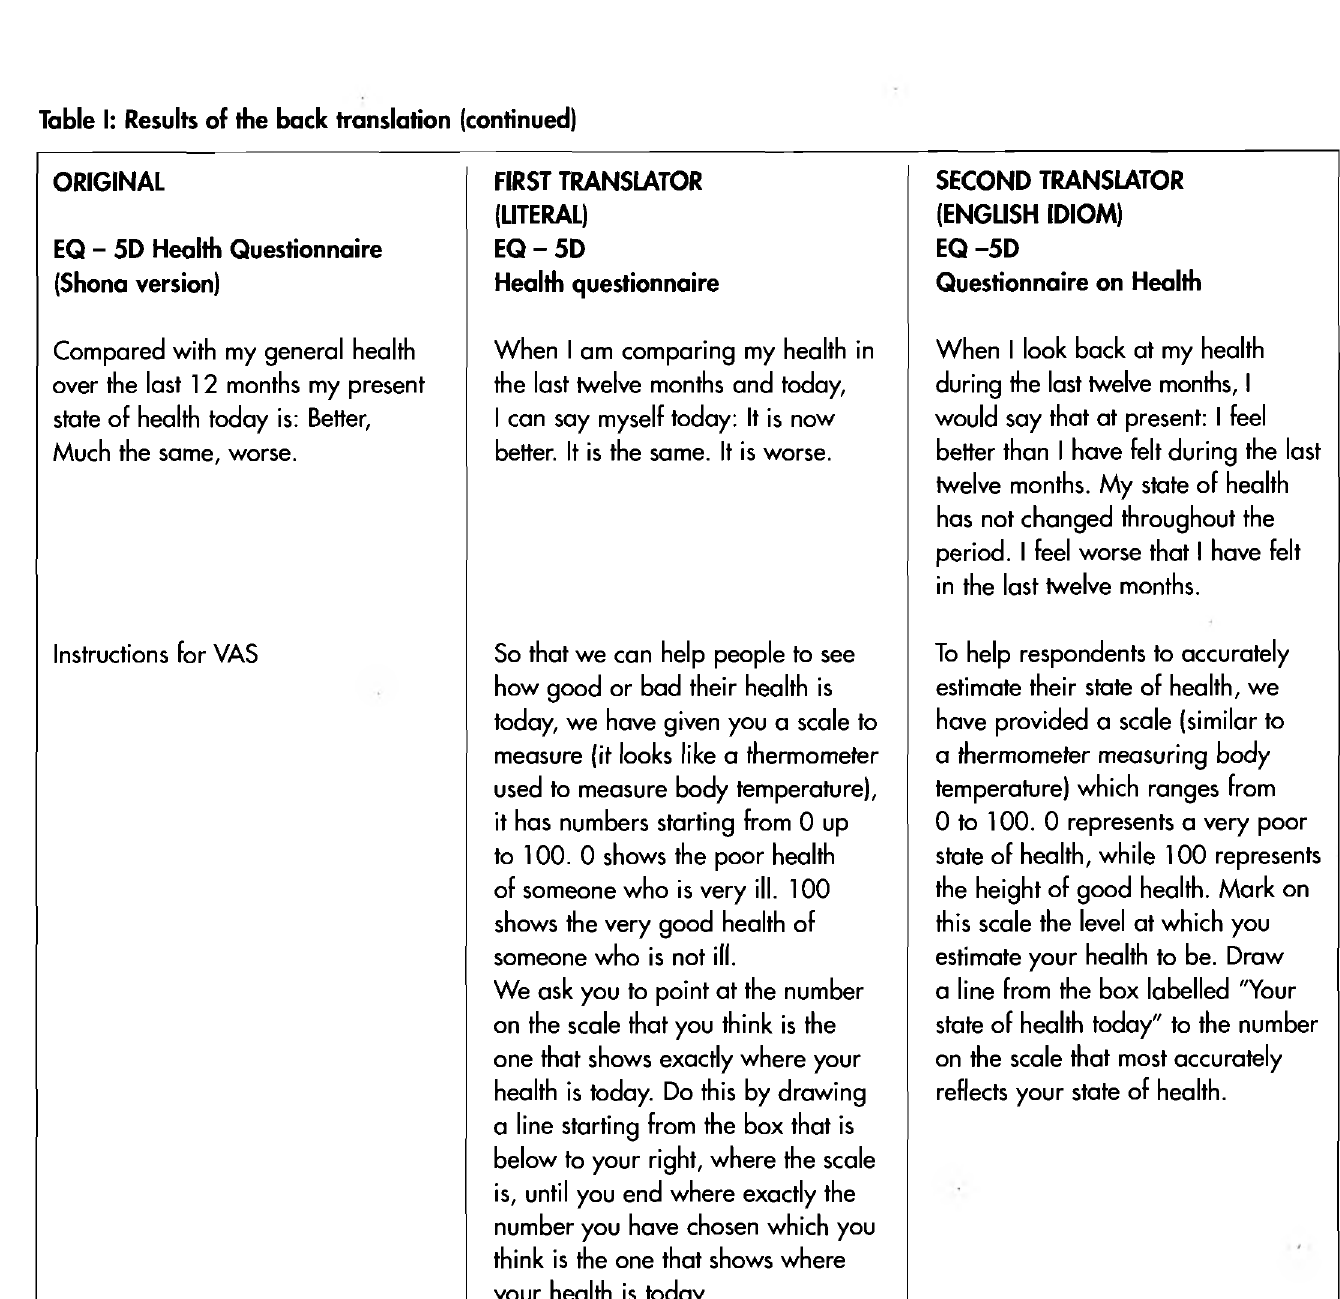
Instructions for